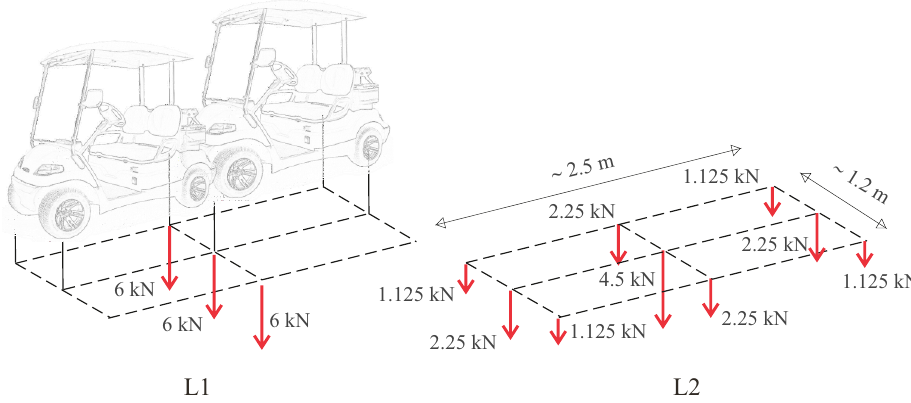
Figure 7. Scheme of load conditions L1 and L2 on S model.